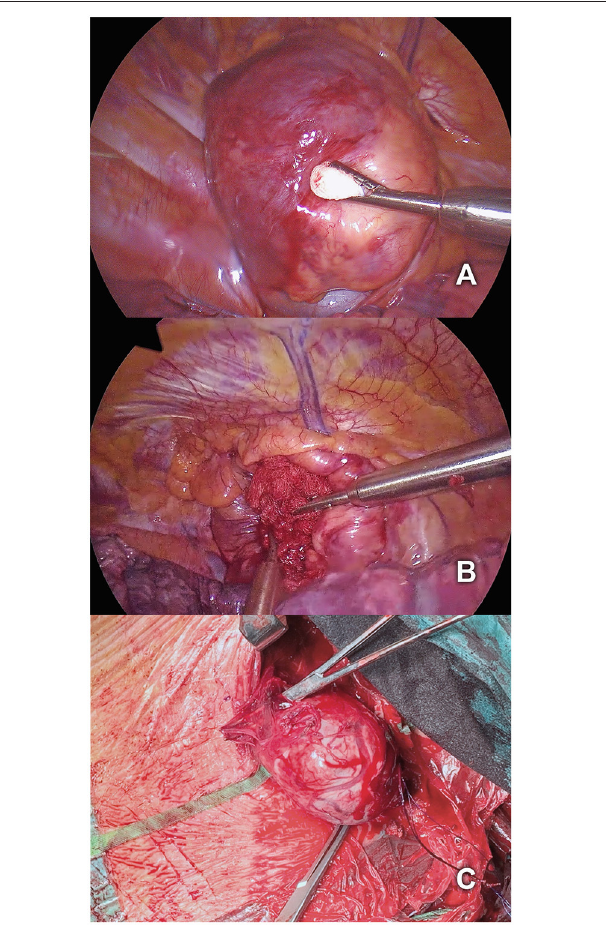
FIGURE 3 | (A) Thoracoscopic visualization of the posterior mediastinal goiter. (B) Mobilization of the goiter by gently pushing it through the thoracic inlet. (C) Simultaneous cervical resection of the right thyroid lobe including the retrosternal